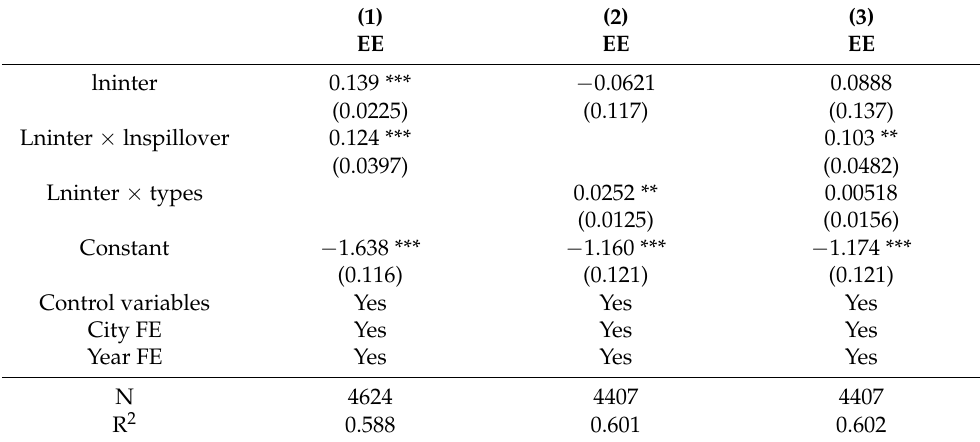
Table 6. Mechanism